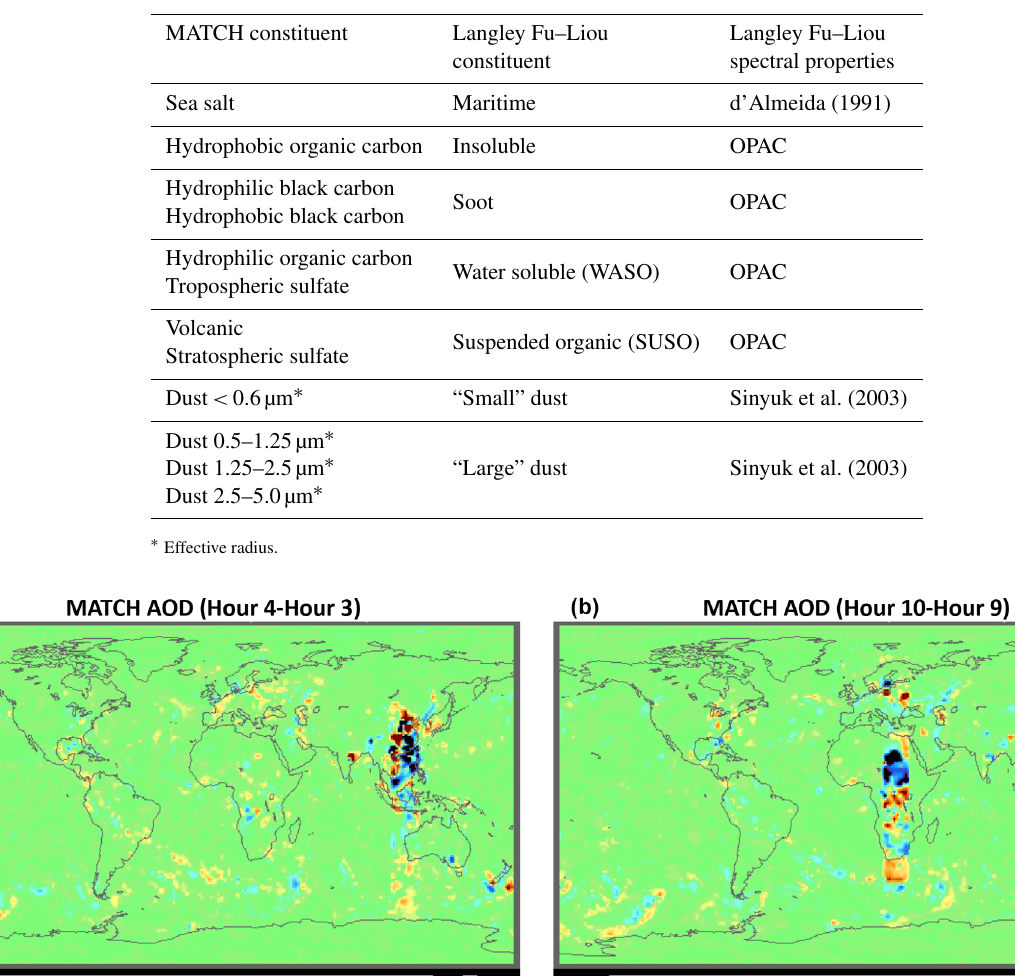
Table 2. Mapping of MATCH aerosol types into radiative transfer code.